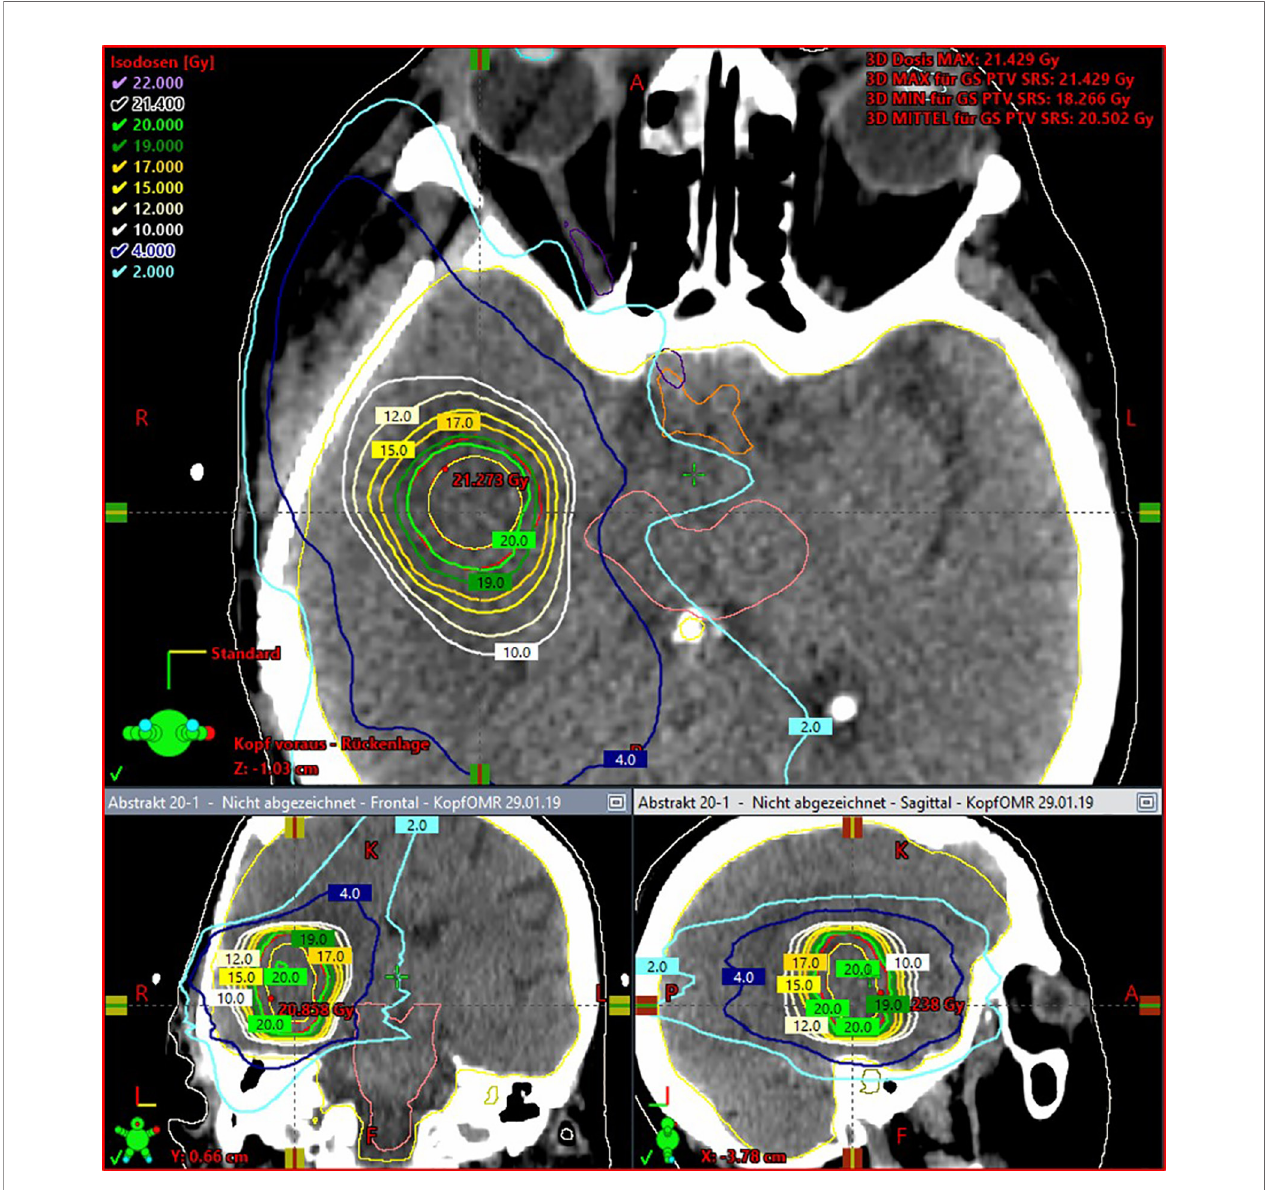
FIGURE 3 | Exemplary case with three-dimensional views of isodose line distribution for upfront SRS boosting, homogeneously delivered to a 2-mm